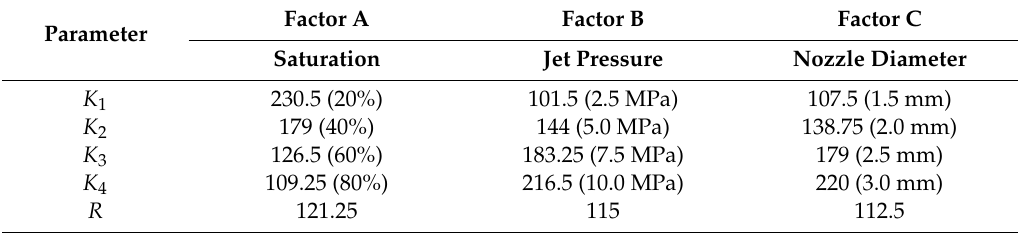
Table 2. Range analysis table of orthogonal design